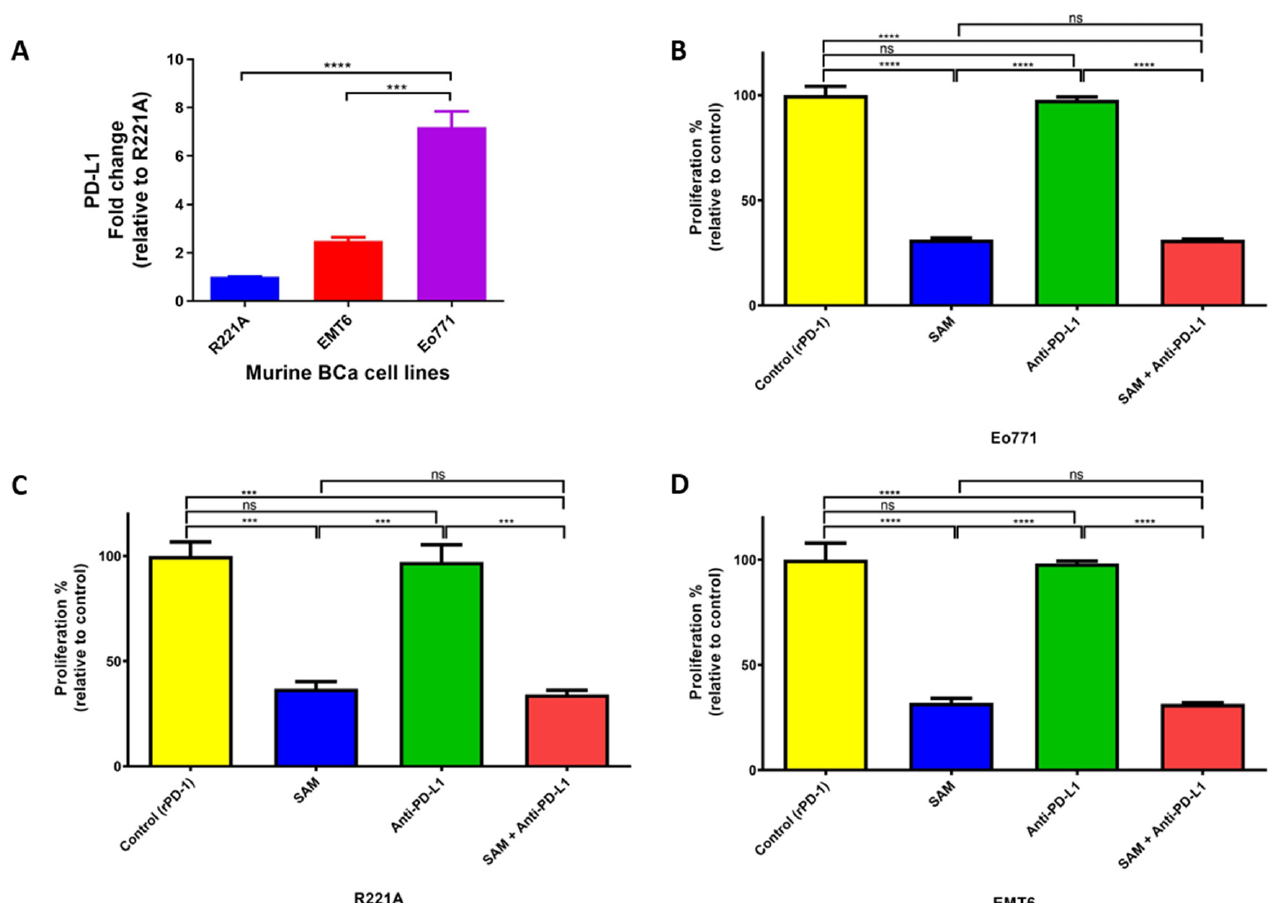
Figure 2. PD-L1 expression and effect of PD-L1 intracellular signaling on cell proliferation of murine BCa cells. ( A ) Expression of PD-L1 in murine BCa cell lines analyzed by RT-qPCR. The fold change was relative to the expression of R221A. ( B – D ) Effect of SAM and anti-PD-L1 antibody on proliferation of murine BCa cells. ( B ) Eo771 (4 × 10 4 ), ( C ) R221A (1 × 10 4 ), and ( D ) EMT6 (4 × 10 4 ) cells were seeded in 6-well plates and were added to rPD-1 (0.2 µ g/mL, day 3). The cells were treated with either control (only rPD-1), SAM (200 µ M, day 2, 3, 4), anti-PD-L1 antibody (50 µ g/mL, day 4), or SAM and anti-PD-L1 in combination. The results are the mean of at least three independent experiments. Proliferation is represented as the percentage proportional to the control ( ±